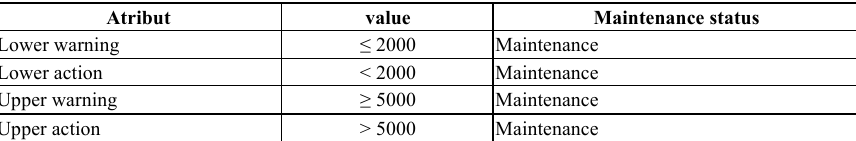
Table 7. Warning and maintenance